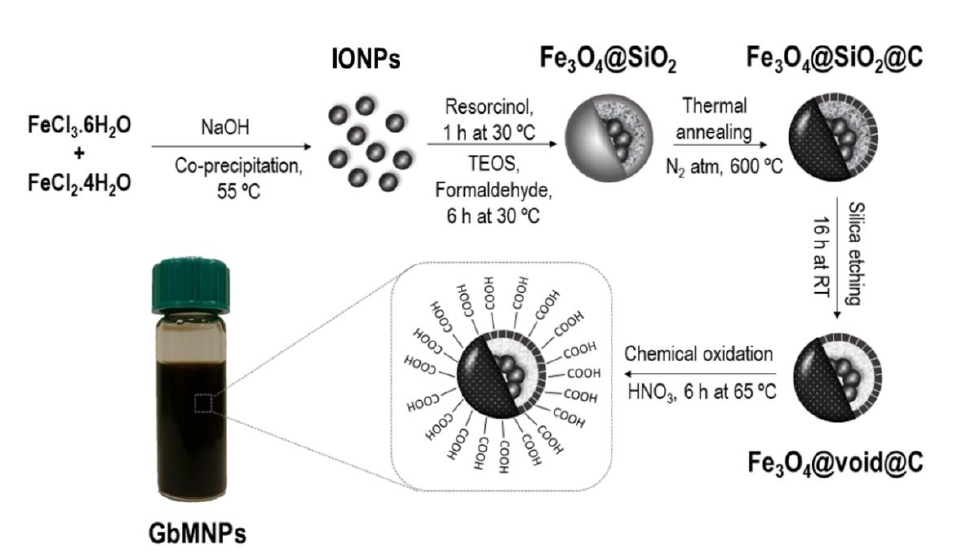
Figure 1. The schematic representation of the synthetic steps involved in the development of the graphene-based yolk-shell magnetic nanoparticles (GbMNPs).